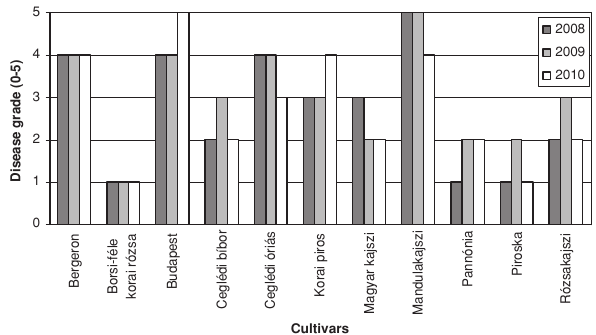
Figure 1: Susceptibility of fruit of apricot cultivars to Monilinia spp. (Kecskemét, 2008–2010)